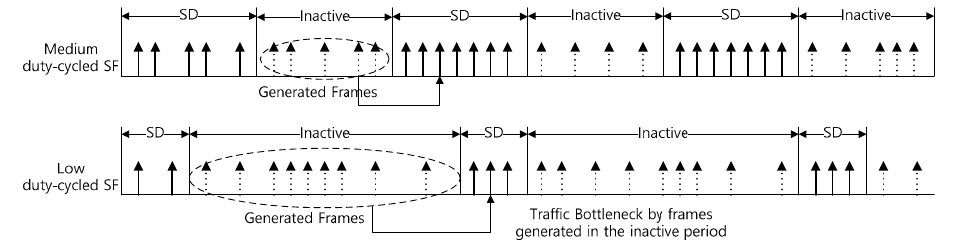
Figure 2. An example of data transmission in IEEE 802.15.4 standard.